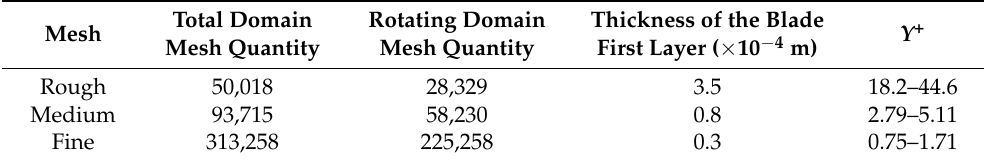
Table 2. Detailed mesh